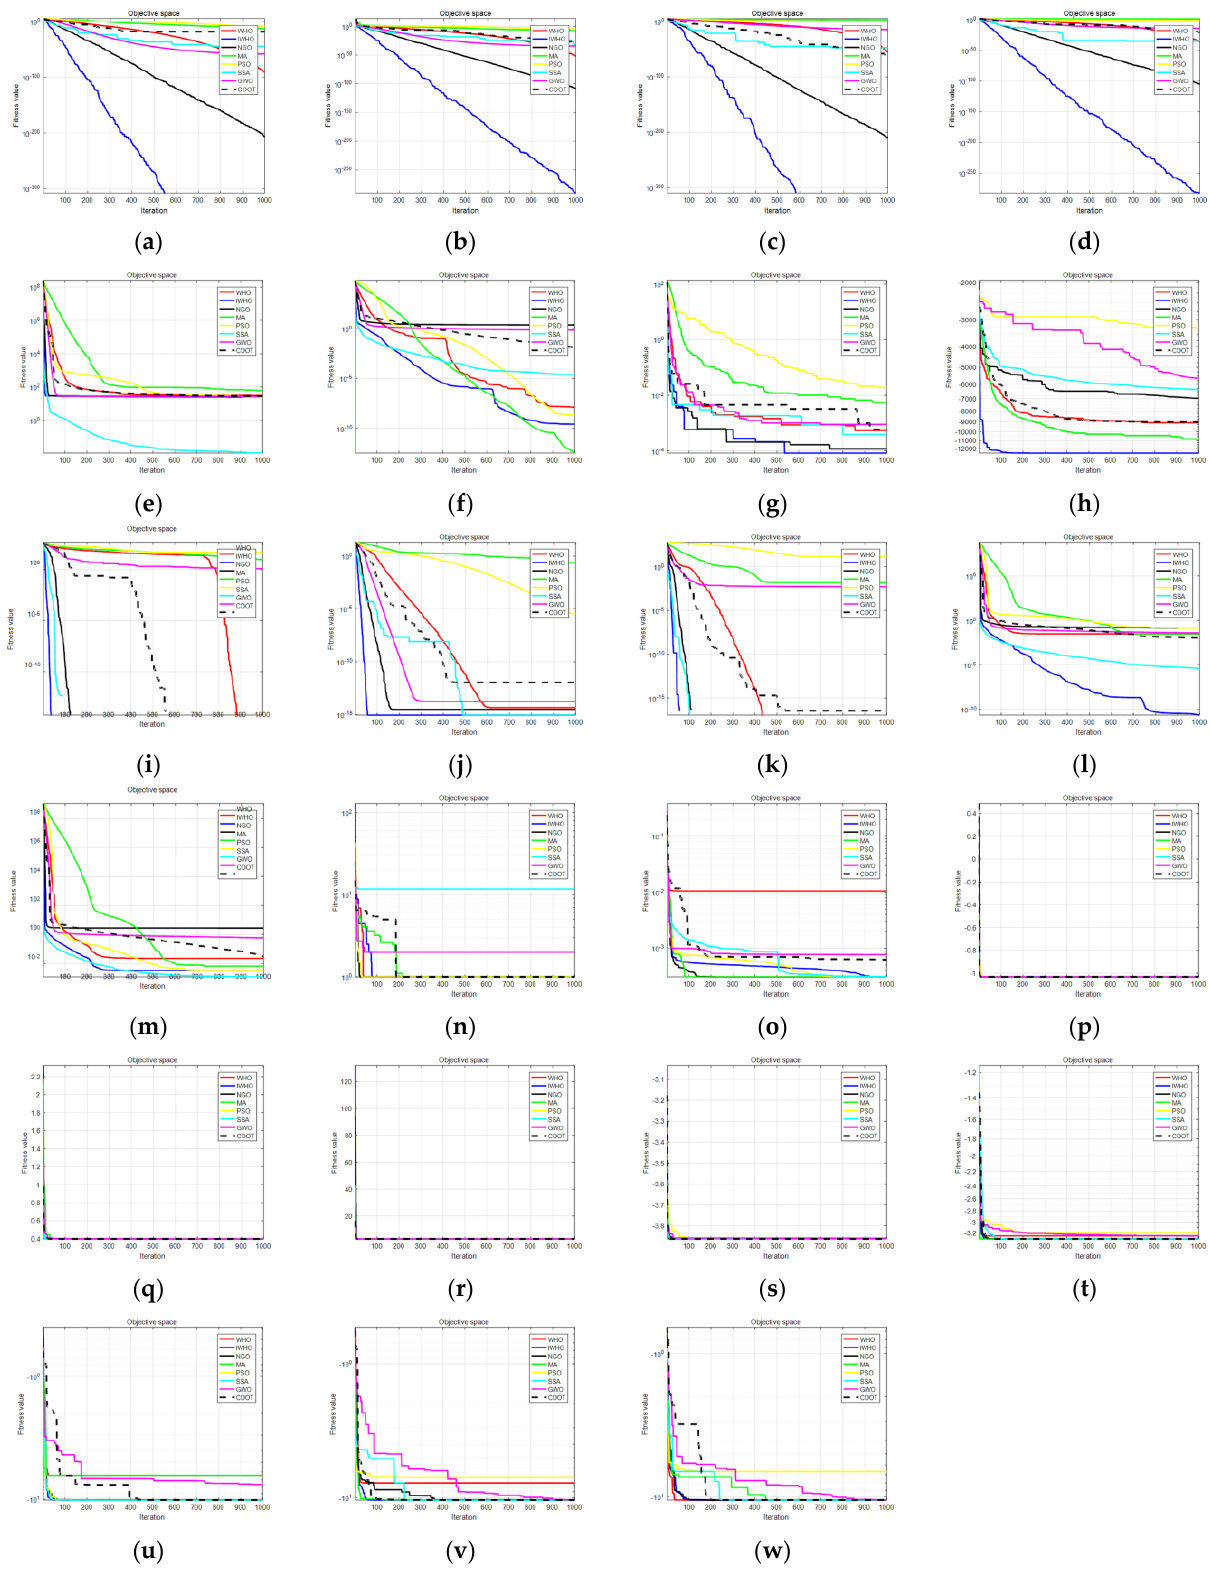
Figure 5. Comparison of convergence curves. ( a ) F1; ( b ) F2; ( c ) F3; ( d ) F4; ( e ) F5; ( f ) F6; ( g ) F7; ( h ) F8; ( i ) F9; ( j ) F10; ( k ) F11; ( l ) F12; ( m ) F13; ( n ) F14; ( o ) F15; ( p ) F16; ( q ) F17; ( r ) F18; ( s ) F19; ( t ) F20; ( u ) F21; ( v ) F22; ( w ) F23.